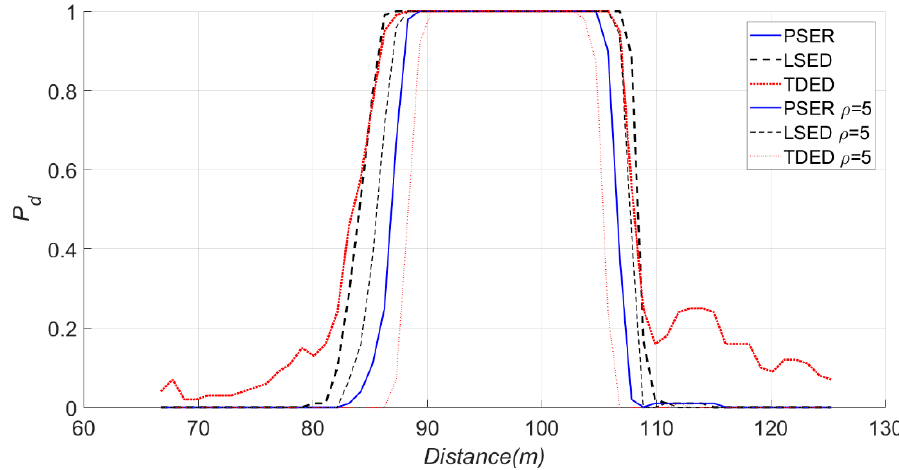
Figure 27. Effects of noise uncertainty on the PSER, LSED, and TDED, where ρ = 5.